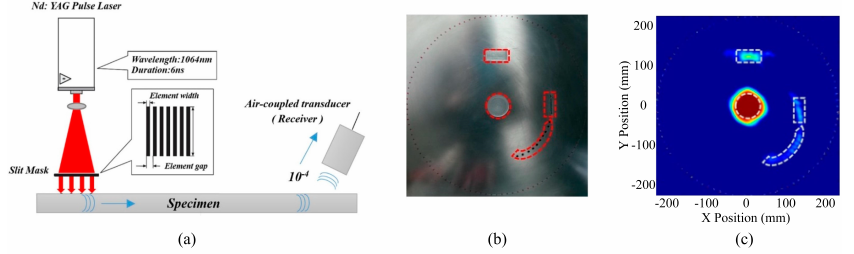
Figure 11. Robotic arm-assisted automated detection system and imaging results [111]. ( a ) PL-ACT tomography detection system. ( b ) Multi-damage sample. ( c ) Results of high-precision tomogra- phy